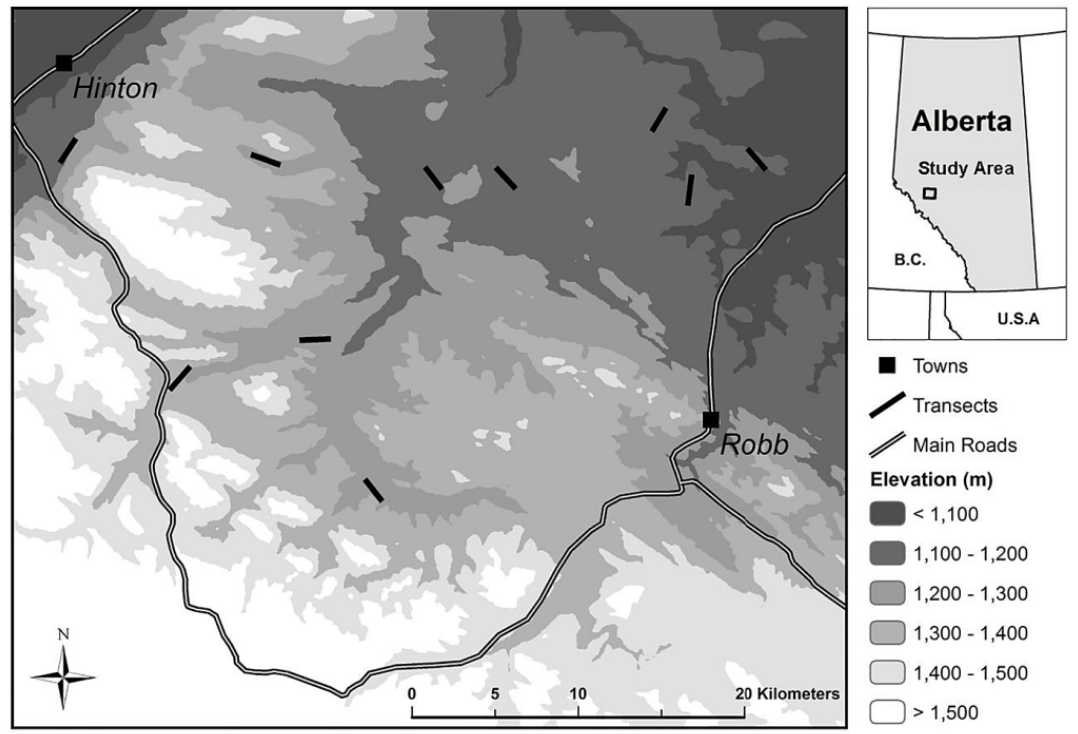
Figure 1. Location and elevation of 2-km transects ( n = 10) established in 2015 across the study area southeast of Hinton, Alberta (53°24 ′ 41 ″ N, 117°33 ′ 50 ″ W).